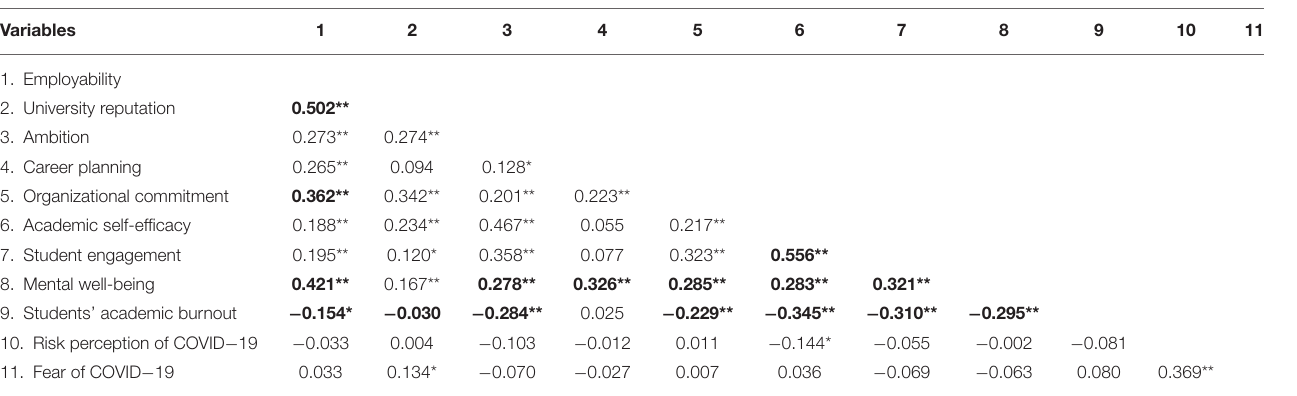
TABLE 3 | Correlations between variables ( N = 269).